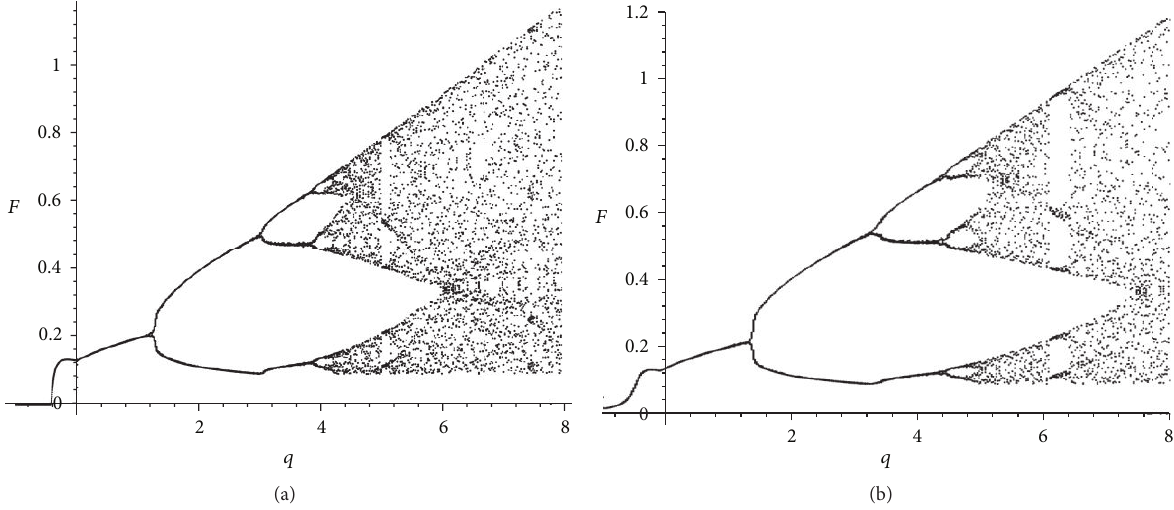
Figure 8: Bifurcation diagrams for system (1) 𝑞 ∈ (−1,8] , where (a) 𝜏 = 0 and (b) 𝜏 = 0.009